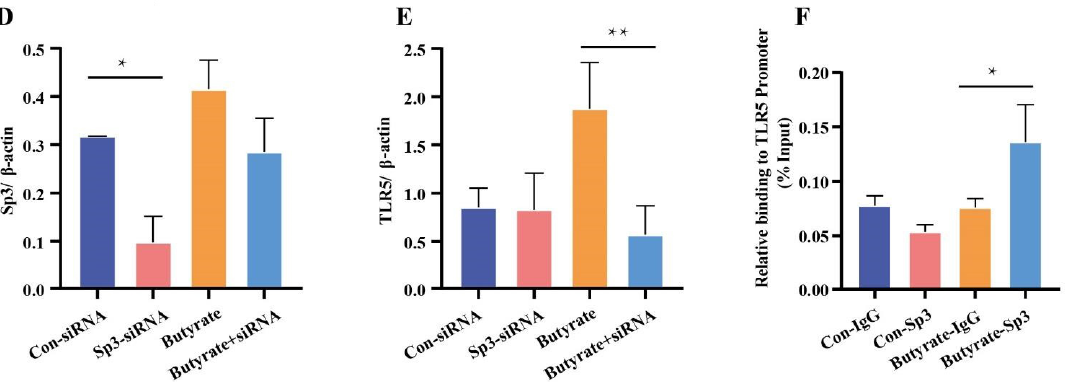
Figure 6. Butyrate regulates TLR5 expression through the transcription factor Sp3. ( A ) Control siRNA and Sp3-specific siRNA with and without butyrate were transfected into HT29 cells. After 48 h, Sp3 mRNA expression and TLR5 mRNA expression ( B ) were detected by RT‒qPCR. ( C ) Western blot analysis and quantification of TLR5 and Sp3 protein expression after transfection with control siRNA and Sp3-specific siRNA in the control and butyrate groups. ( D , E ) A representative image of Western blot analysis. ( F ) ChIP-sequencing analysis of Sp3 in HT29 cells treated with butyrate. ChIP assays with H3 and Sp3 antibodies in butyrate-treated or untreated HT29 cells. qPCR showed H3 and Sp3 binding to the TLR5 promoter or RPL30 promoter. * p < 0.05 and ** p < 0.01.